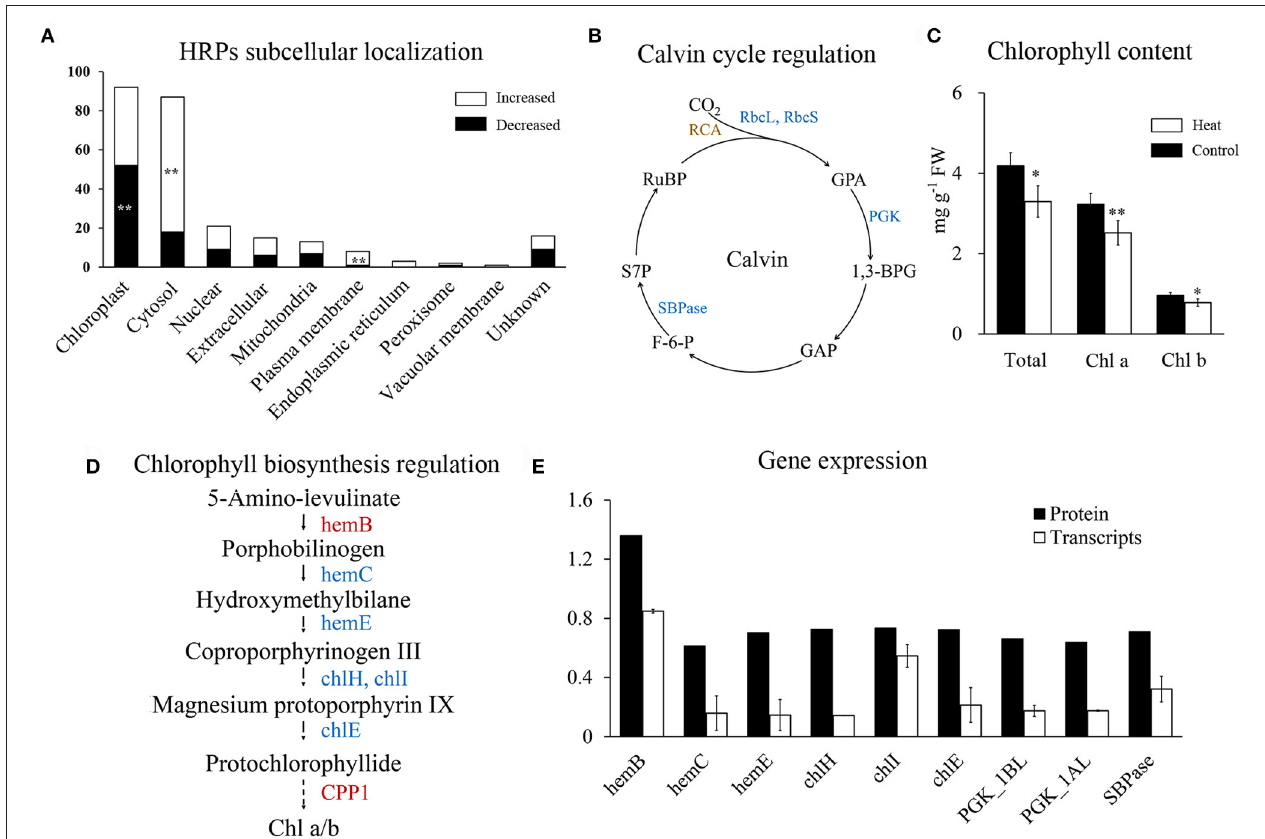
FIGURE 5 | Regulation of photosynthesis in wheat leaf under heat stress. (A) Subcellular localization of HRPs predicated by Wolfpsort. White bars represent increased proteins, black bars represent decreased proteins. (B) Map of Calvin cycle regulation. Blue represent decreased, brown represent differentially regulated. 1,3-BPG, 1,3-Bisphospho-D-glycerate; F-6-P, D-Fructose 6-phosphate; GAP, D-Glyceraldehyde 3-phosphate; GPA, D-Glycerate 3-phosphate; PGK, phosphoglycerate kinase; RCA, Rubisco activase; rbcL, Rubisco large chain, rbcS; Rubisco small chain; RuBP, D-Ribulose 1,5-bisphosphate; S7P, D-Sedoheptulose 7-phosphate; SBPase, sedoheptulose-bisphosphatase; (C) Chlorophyll content of wheat flag leaves. Asterisk represent significantly different at p < 0.05 level, double asterisks at 0.01 level. (D) Map of chlorophyll biosynthesis regulation. Red represent increased, blue represent decreased. chlE, magnesium-protoporphyrin